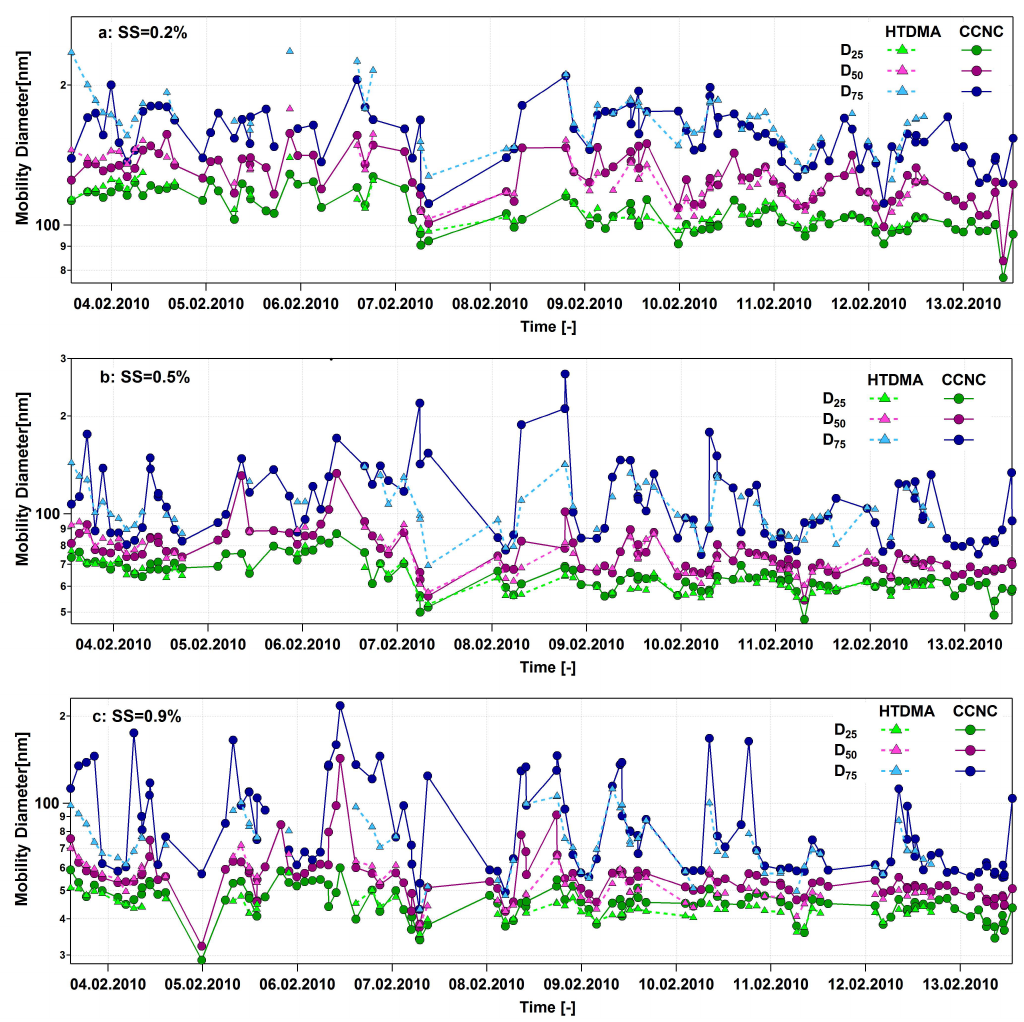
Fig. 9. The time evolution of D 25 , D 50 and D 75 of the D crit distributions ( ∂ AF/ ∂D ) at 0.2% (a) , 0.5% (b) and 0.9% (c) SS as measured by the CCNC (filled circles) and predicted by the HTDMA (filled